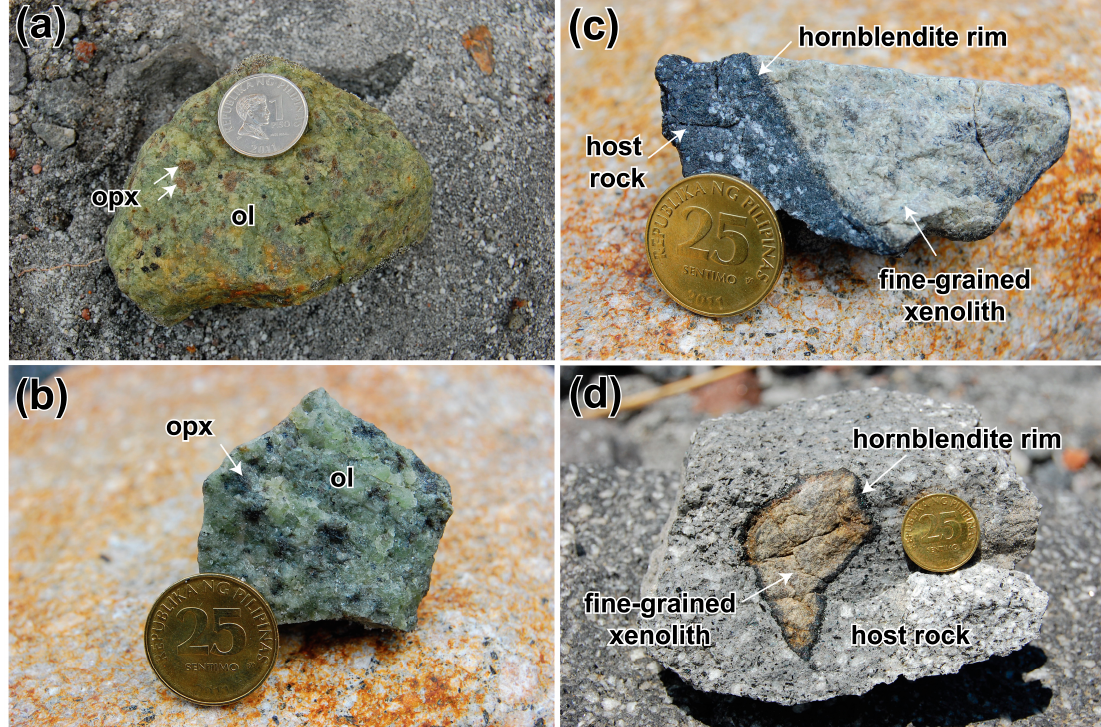
Figure 2. Mantle xenoliths in Mt. Pinatubo. ( a , b ) Coarse-grained spinel harzburgite xenoliths with large orthopyroxenes. ( c , d ) Well-preserved fine-grained spinel harzburgite xenoliths rimmed by hornblendite. Abbreviations: ol = olivine and opx = orthopyroxene. Size of coin in ( a ) is 2.3 cm and in ( c , d ) is 2